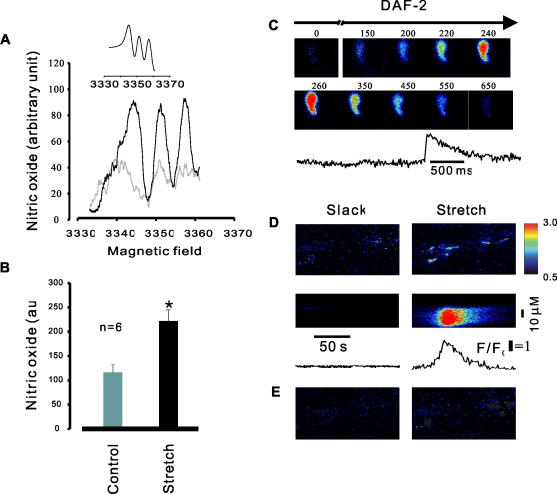
Stretch-induced NO production in single cell and intact smooth muscle tissues.A, ESR spectra of NO trapped by DETC-iron (II) complex in mouse bladder smooth muscle strips. Compared to control (slack tissue strips, gray line), NO was greatly increased in stretched tissue strips (black line). The inset shows the magnetic field range of NO in the presence of SNP. B, summary data of NO production. Note the significantly difference of NO production between the control group and stretch group; * P<0.01, n = 6. C, DAF-2 single cell experiments: by stretch the cell length to ΔL = 9% DAF-2 fluorescence transient occurred immediately. D, upper is x-y images taken from a tissue strip incubated with DAF-2; the lower is pseudo linescan images taken from a series of x-y image obtained from before (left) and after (right) stretch of the intact mouse bladder smooth muscle strip incubated with DAF-2, and at below of pseudo linescan images show NO transient profiles taken from slack and stretch. E, before ( left ) and after ( right ) stretch of tissue segment in the presence of L-name. Note that the stretch-induced NO production was completely inhibited by L-name.